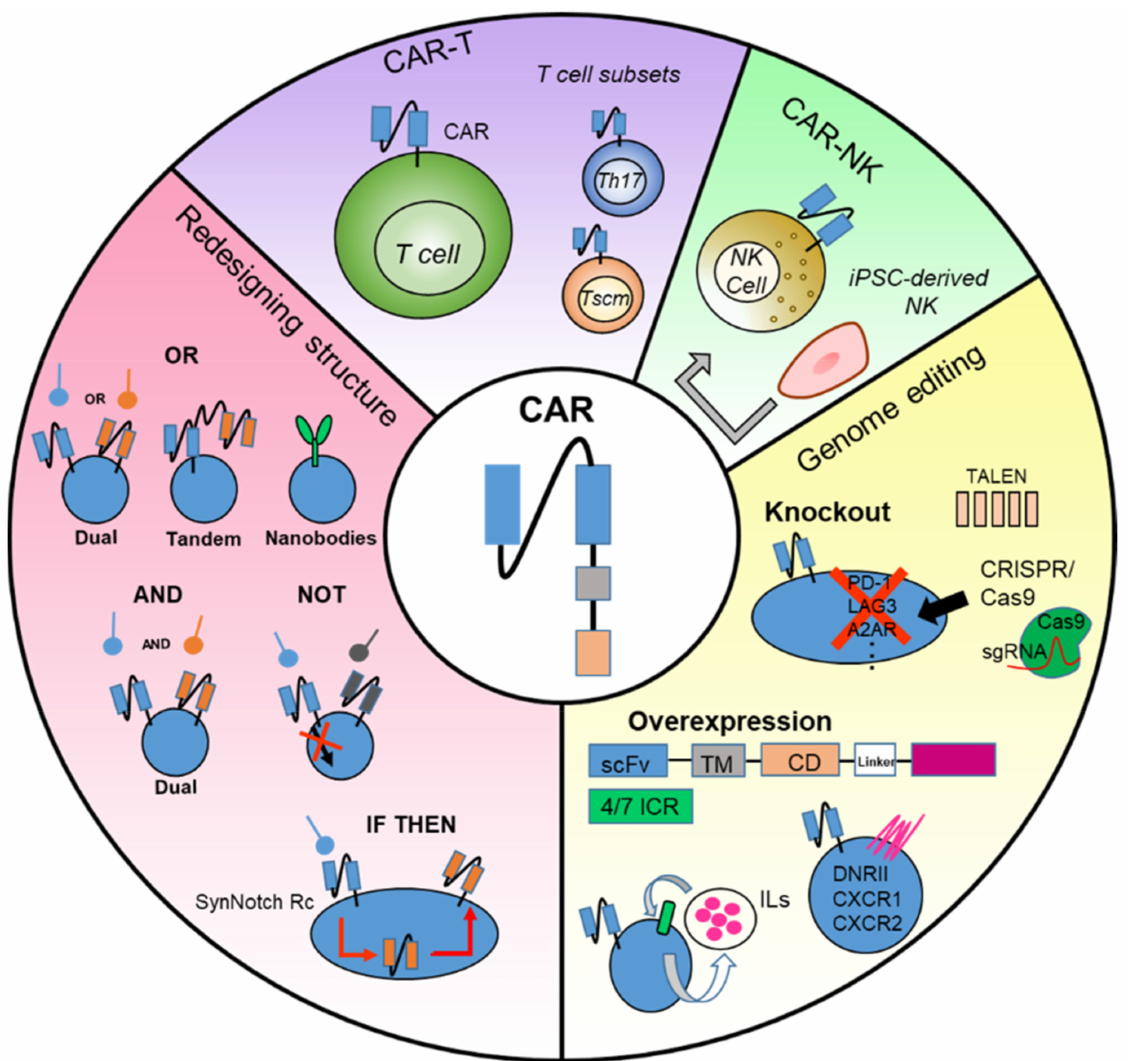
Figure 1. Summary of novel approaches for employing chimeric antigen receptors (CARs). CAR construct has been advanced and redesigned to express a variety of combinations, including diverse scFvs and intracellular signaling domains. CARs can be expressed in either T cells, T cell subsets, or NK cells to develop anti-tumor immune cell and gene therapies. Additional gene engineering has been conducted in immune cells to enhance the CAR-T cell persistence and anti-tumor efficacy. Th17 —T helper 17; Tscm —stem cell-like memory T cell; iPSC —induced Pluripotent stem cell; NK —natural killer; TALEN —transcription activator-like effector nucleases; CRISPR —clustered regularly interspaced short palindromic repeats; sgRNA —single guide RNA; PD-1 —programmed cell death-1; LAG3 —lymphocyte activation gene 3; A2AR —A2A adenosine receptor; DNRII —TGF- β dominant negative receptor II; scFv —single chain variable fragment; TM —transmembrane; CD —cytoplasmic domain; ICR —inverted cytokine receptor; ILs